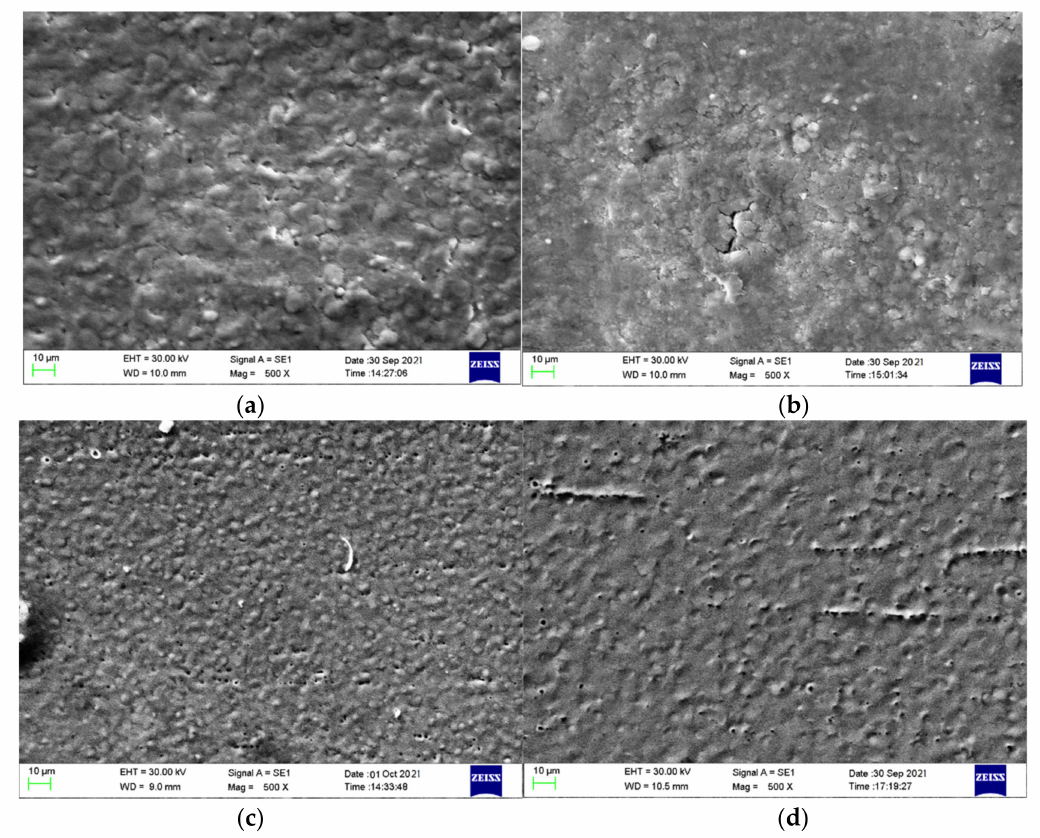
Figure 5. The SEM photographs of the surface machined in dielectric mixed with nano particle surfactants of ( a ) deionized water, ( b ) TiO 2 , ( c ) ZrO 2 , and ( d ) Al 2 O 3